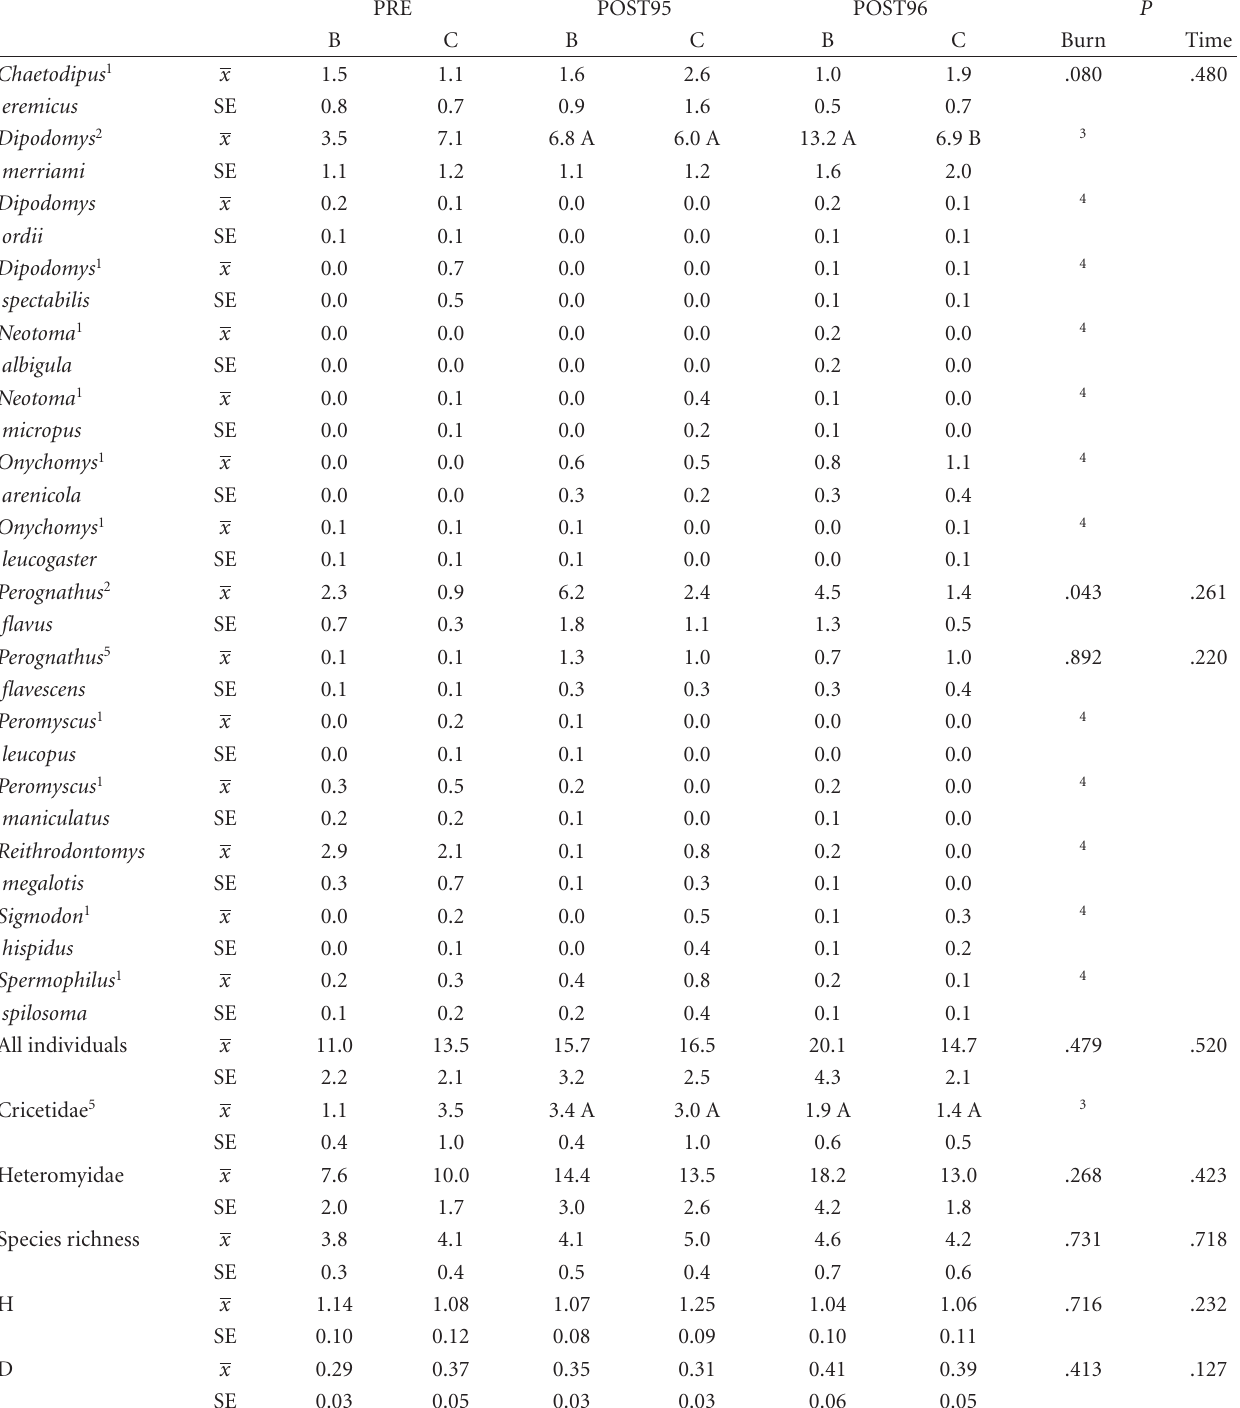
Table 5: Relative abundance (minimum number alive per 25ha) of small mammals, small mammal species richness, and Shannon’s (H) and Simpson’s (D) diversity indices prior to burning in May 1995 (PRE), one month post burn, July 1995 (POST-95), and one year post burn, July 1996 (POST-96), on 10 pairs of burned (B) and control (C) study sites on Fort Bliss Military Reservation, Otero County, New